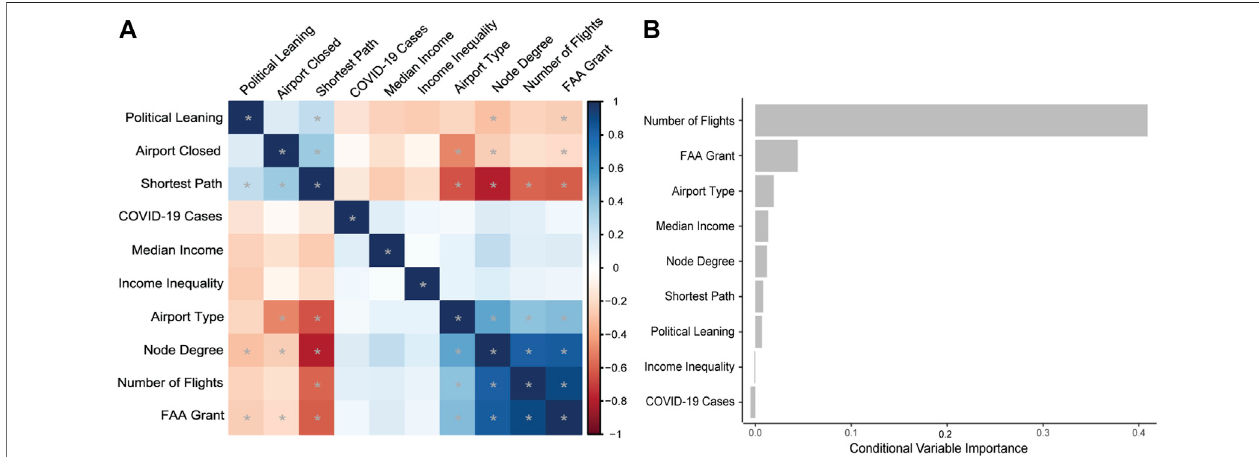
FIGURE 4 | Random Forest results. (A) Correlation matrix with signi fi cant correlations p < 0 . 05 (*) between model variables. Positive correlations are visualized in shades of blue and negative correlations in shades of red. Correlations are ordered by hierarchical clustering. (B) Importance of variables expressed by conditional variableimportance.Ifavariable is “ important, ” its addition tothemodel reduces classi fi cation errorbythelargest amount. The “ important ” variable doesnot necessarily need to be highly correlated with the target variable (closed airports) since they do not need to have a linear relationship.